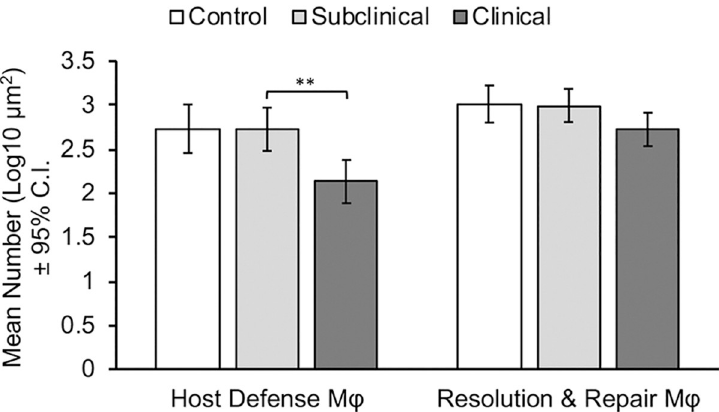
Fig 4. Mean number (Log μ m 2 ) of total macrophages (AM-3K) classified as either host defense or regulation of inflammation macrophages. IF staining was performed on frozen bovine mid-ileal tissue sections collected from cows naturally infected with Mycobacterium avium subsp. paratuberculosis (subclinical and clinical), compared to uninfected control cows. Asterisks denote statistical significance: �� p <